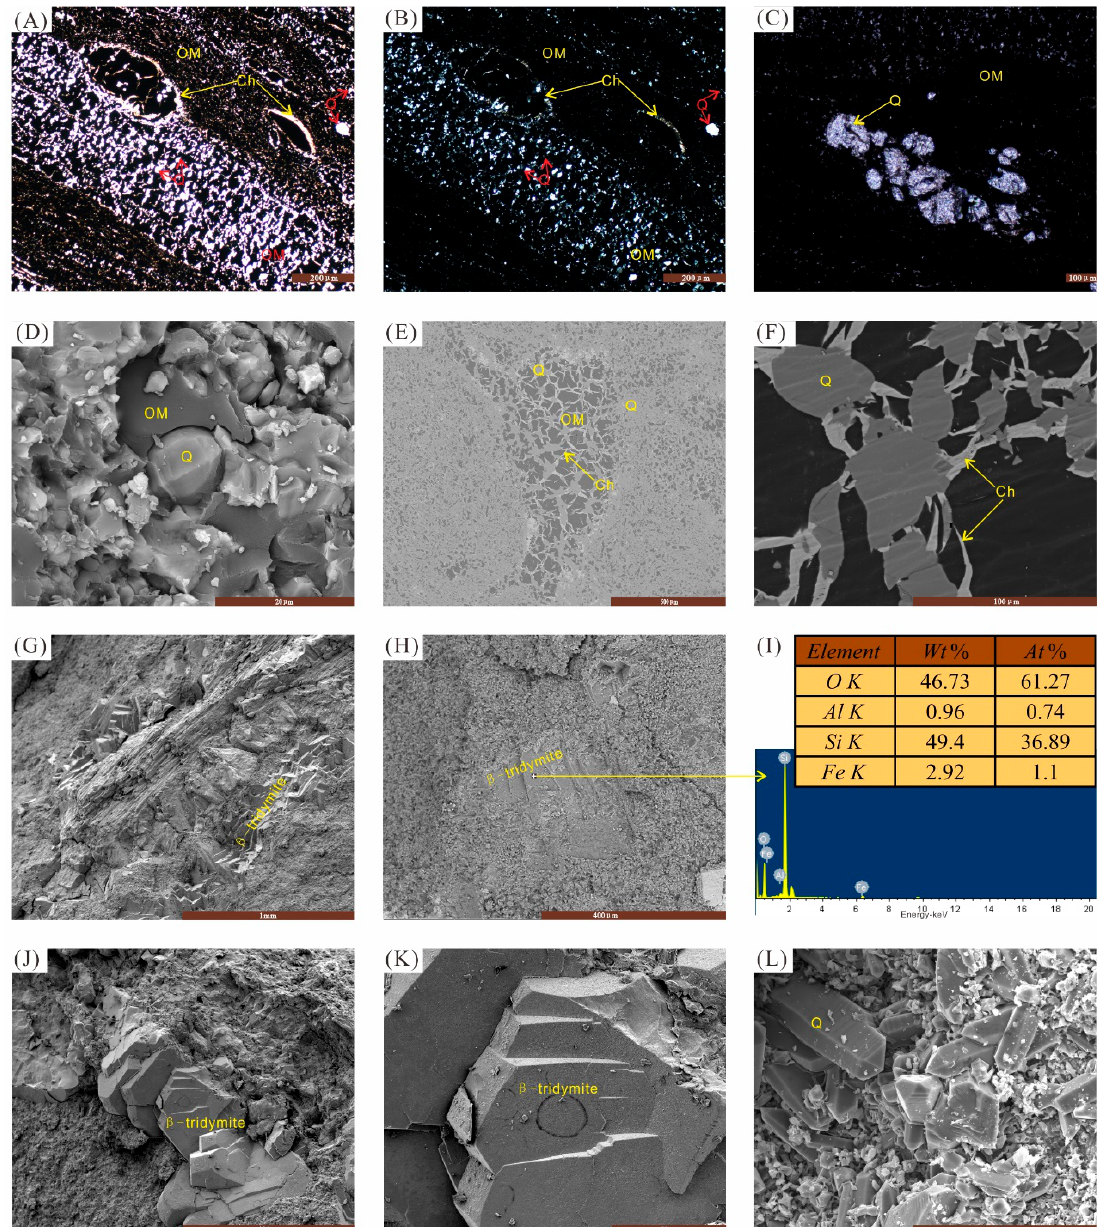
Figure 4. Quartz occurrence modes in coal. ( A ) Fine-grained quartz grains appear as angular fragments or corroded particles restricted to organic matter in plane-polarized light (PPL); ( B ) Photomicrographs of ( A ) under polarized light (XPL); ( C ) Discrete larger well-developed quartz in organic matter in PPL; ( D ) Discrete authigenic quartz particle in organic matter SEM BSED; ( E ) Quartz as cleat/fracture infillings closely associated with chamosite SEM BSED; ( F ) Quartz as cleat/fracture infillings closely associated with chamosite SEM BSED; ( G ) β -tridymite arranged in clusters and shingles SEM BSED; ( H ) β -tridymite arranged in clusters and shingles SEM secondary electron images (ETD); ( I ) EDS data for β -tridymite; ( J ) β -tridymite occurring as hexagonal plates and arranged in clusters and shingles SEM ETD; ( K ) Magnification of ( J ) SEM ETD; ( L ) Authigenic quartz particles SEM ETD. Q, quartz; Ch, chamosite; OM, organic matter. ( D , G , H , J – L ) naturally exposed surface; ( E , F ) ion-polished surface.